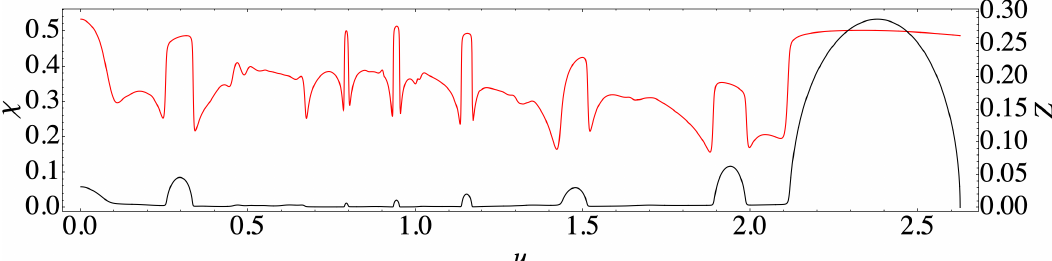
Figure 2 . χ (in red) on the AH plotted against the embedding coordinate u near the endpoint of the ultraspinning instability of a MP BH in 6 D with an initial spin parameter a/µ 1 / 3 = 1 . 85 (see [20] for more details); the Z coordinate of the embedding is shown in black and it serves to guide the eye. This figure shows that on the AH, χ ∼ 0 . 5 on the blobs and χ ∼ 0 . 3 on the